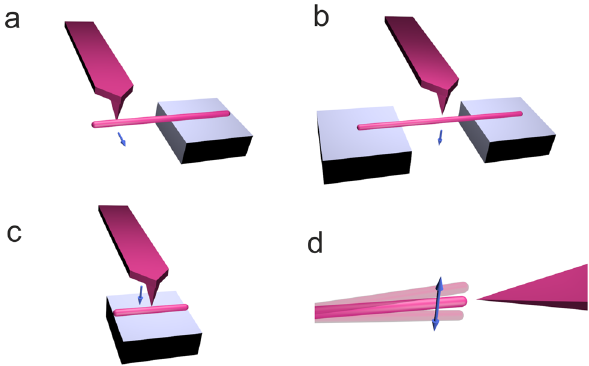
Figure 3: Schematics of ( a ) cantilever beam, ( b ) 3 - point bending, ( c ) nanoindentation, and ( d ) resonance method test schemes. Arrow indicates the direction of the applied external